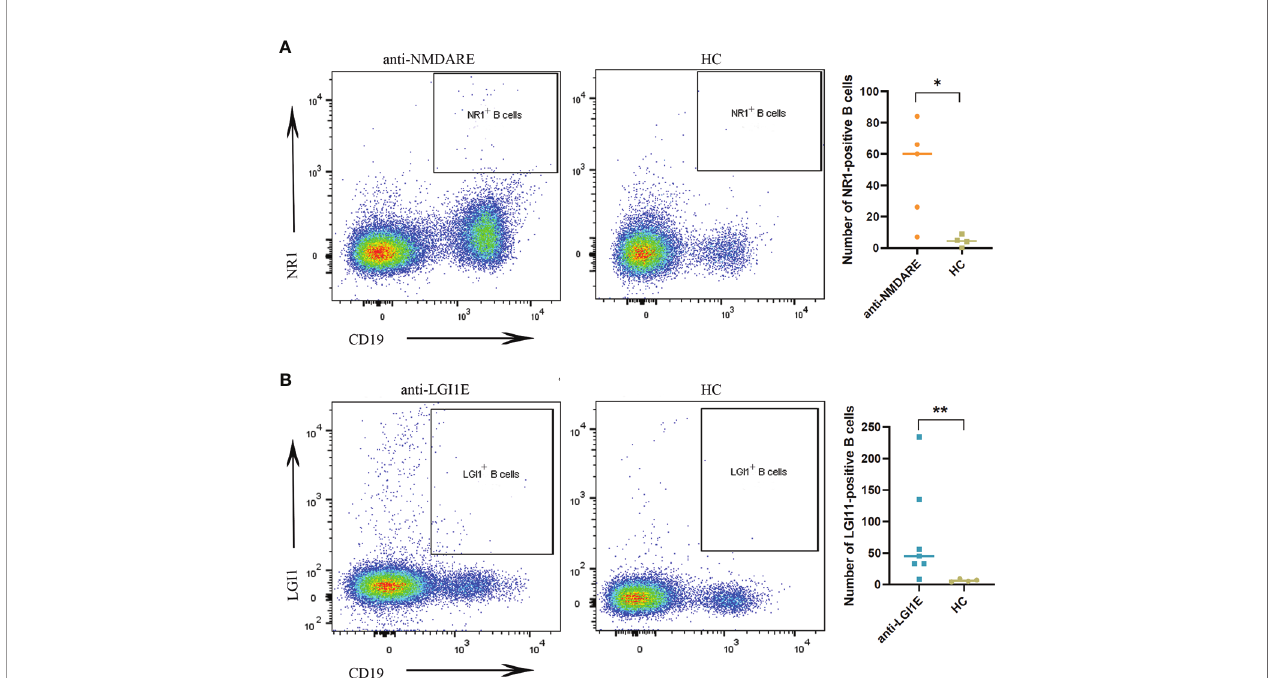
FIGURE 1 | Comparison of NR1-positive B cells and LGI1-positive B cells in peripheral blood samples among the anti-NMDARE, anti-LGI1E, and HC groups. (A) Results of fl ow cytometric analysis of NR1-positive B cells in the anti-NMDARE and HC groups. (B) Results of fl ow cytometric analysis of LGI1-positive B cells in the anti-LGI1E and HC groups. Anti-NMDARE, anti-N-methyl-D-aspartate receptor; anti-LGI1E, anti-leucine-rich glioma-inactivated 1; HC, healthy control. * P < 0.05, ** P <